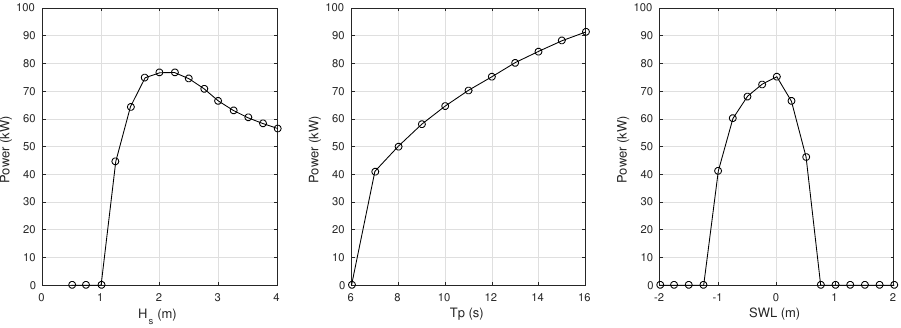
Figure 6. Effect of wave height, period and still water level on power production for Opti1